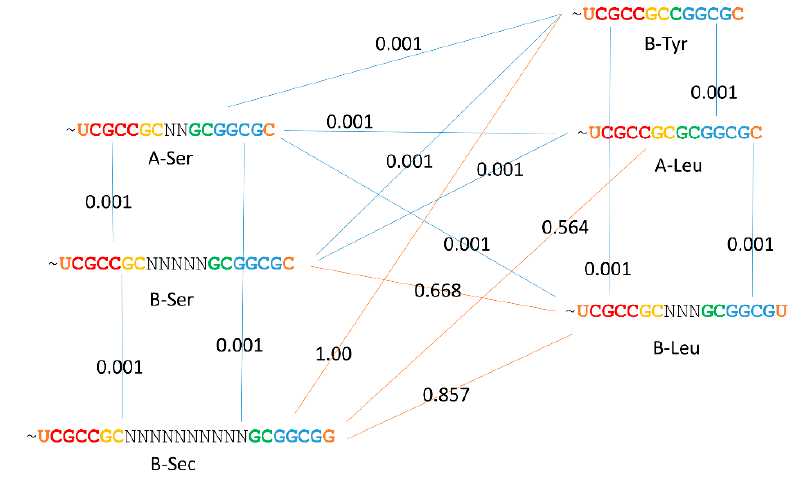
Figure 6. Relatedness of V loop expansions. P -values are shown. Blue lines indicate detected homology. Orange lines indicate V loop divergence (i.e., for aaRS discrimination). “A” indicates archaea. “B” indicates bacteria.